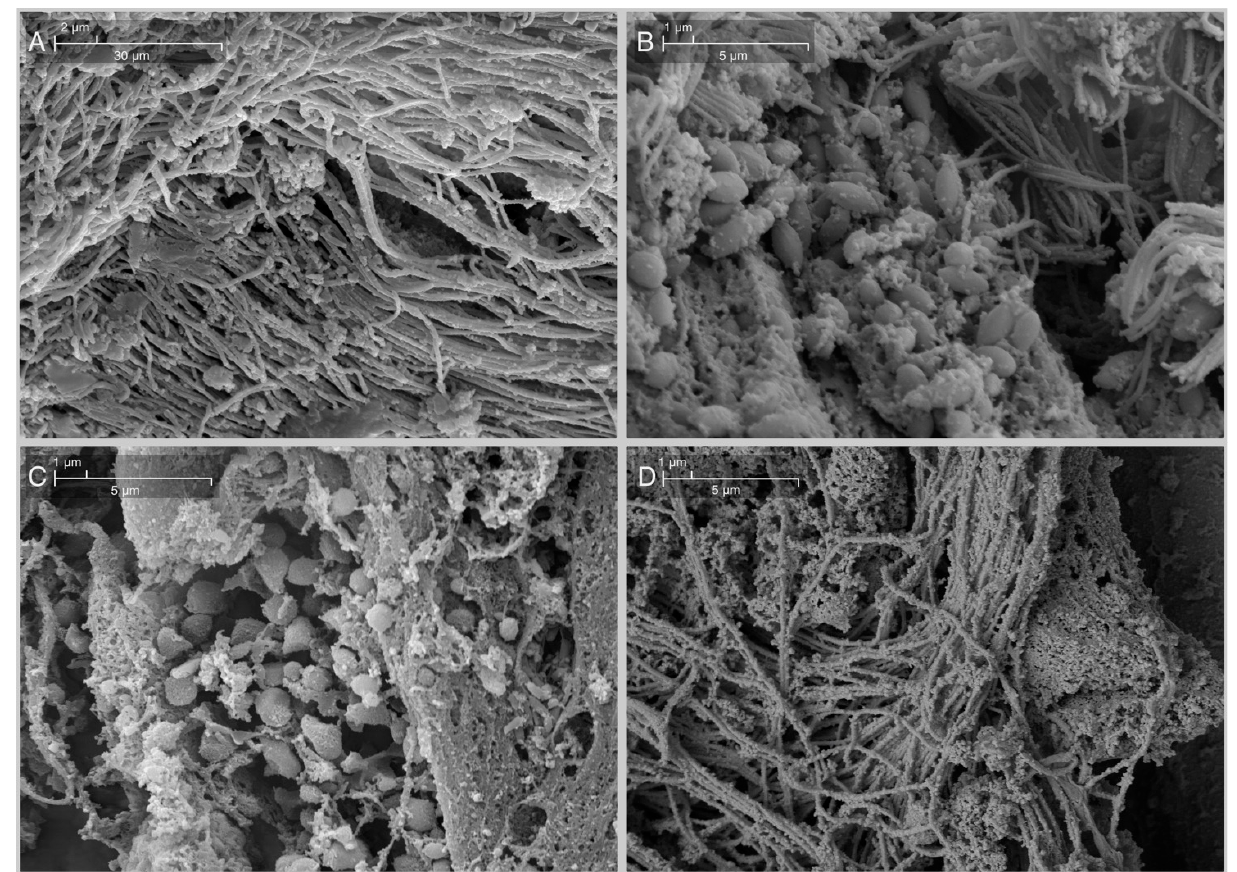
Figure 5. Ctenidium morphology of paratypes of Provanna annae sp. nov. with rod-shaped ( A , B , D ) and almost spherical bacterial cells ( B , C ). Figures ( A , B ) show one specimen, Figures ( C , D ) show another.